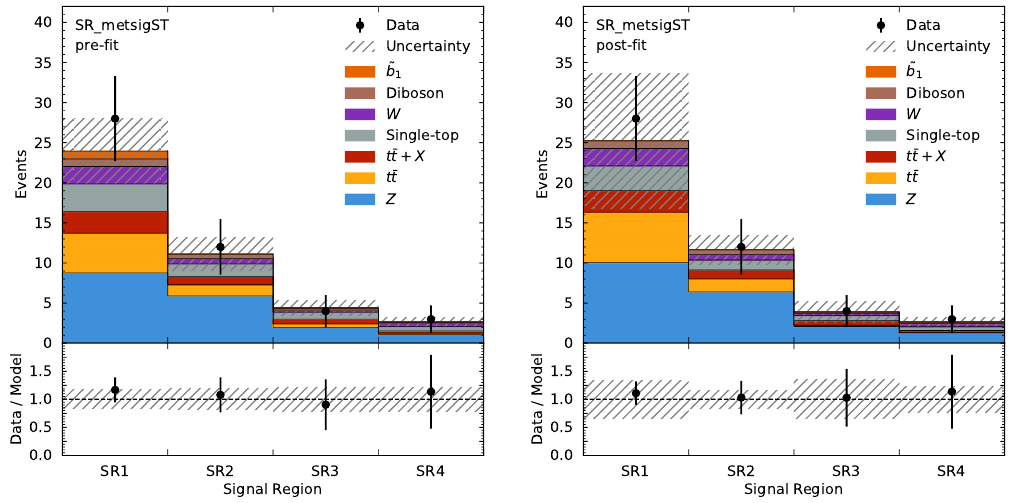
Figure 3: Pre-fit (left) and post-fit (right) visualizations of a selected signal hypoth- esis for four signal regions of the ATLAS search [ 41 ] of a bottom-squark of mass 600 GeV with a second-lightest neutralino of mass 280 GeV and lightest supersym- metric particle of mass 150 GeV generated from the full statistical models published in Ref. [ 20 ] using code from Ref. [ 40 ]